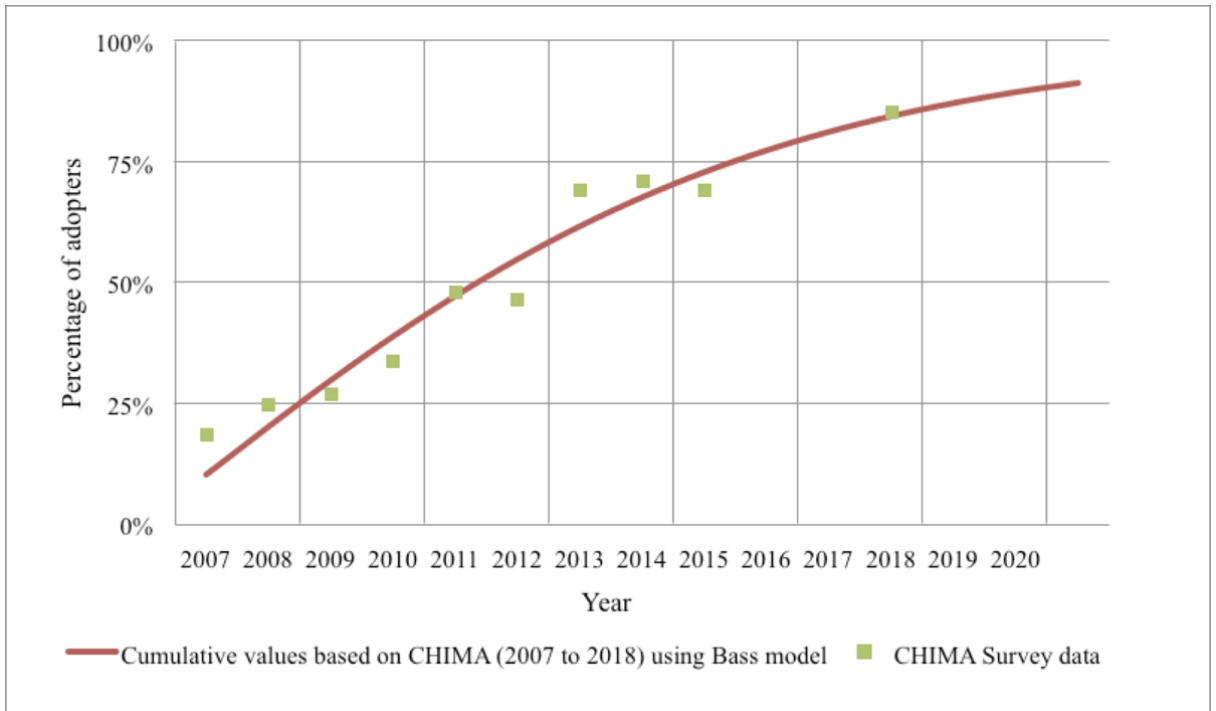
Figure 11. Electronic medical record adoption among Chinese hospitals using the China Hospital Information Management Association Annual Survey (figures for 2016, 2017, and 2020 are forecasted using the Bass mode). CHIMA: China Hospital Information Management